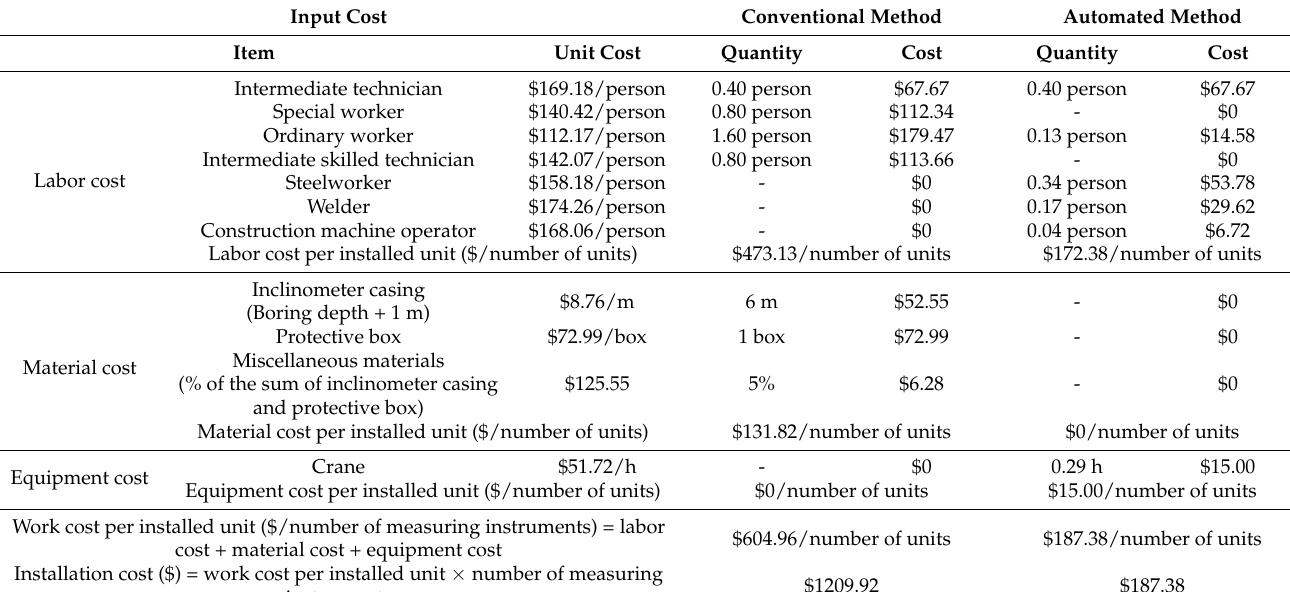
Table 6. Costs for the inclinometer casing (conventional method) and hardware installations (auto- mated method).